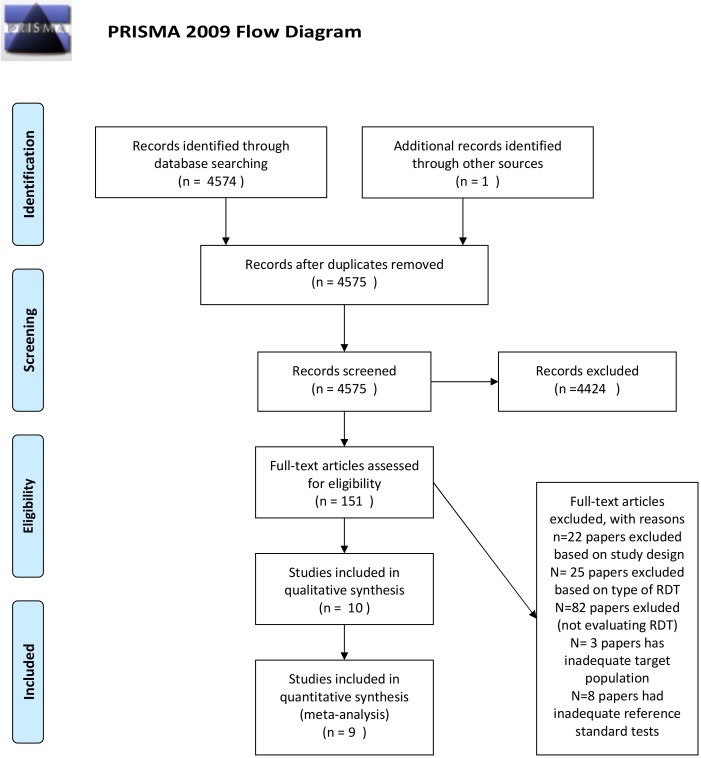
Study flow chart.